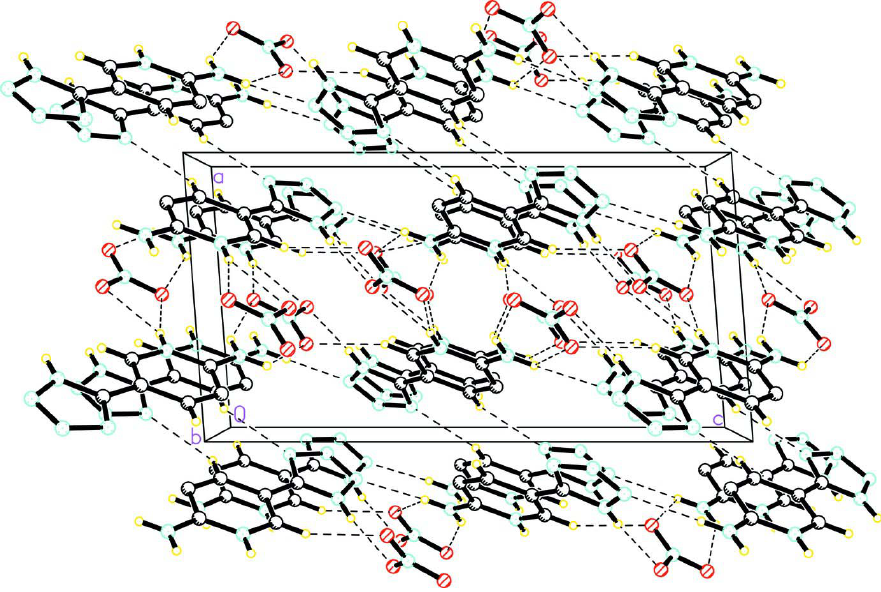
The crystal packing of the title compound viewed along the b axis showing the three-dimensionnal hydrogen bonding network (dashed lines). Hydrogen atoms not involved in hydrogen bonding are omitted for